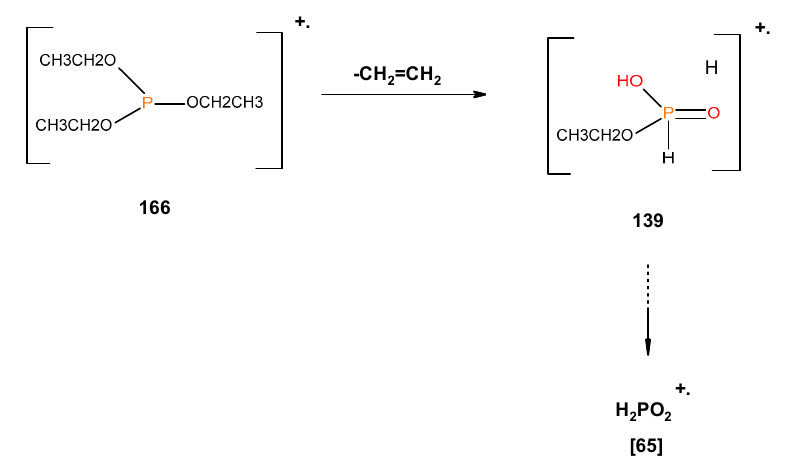
Figure 10. Possible fragmentation pattern for DEPi.